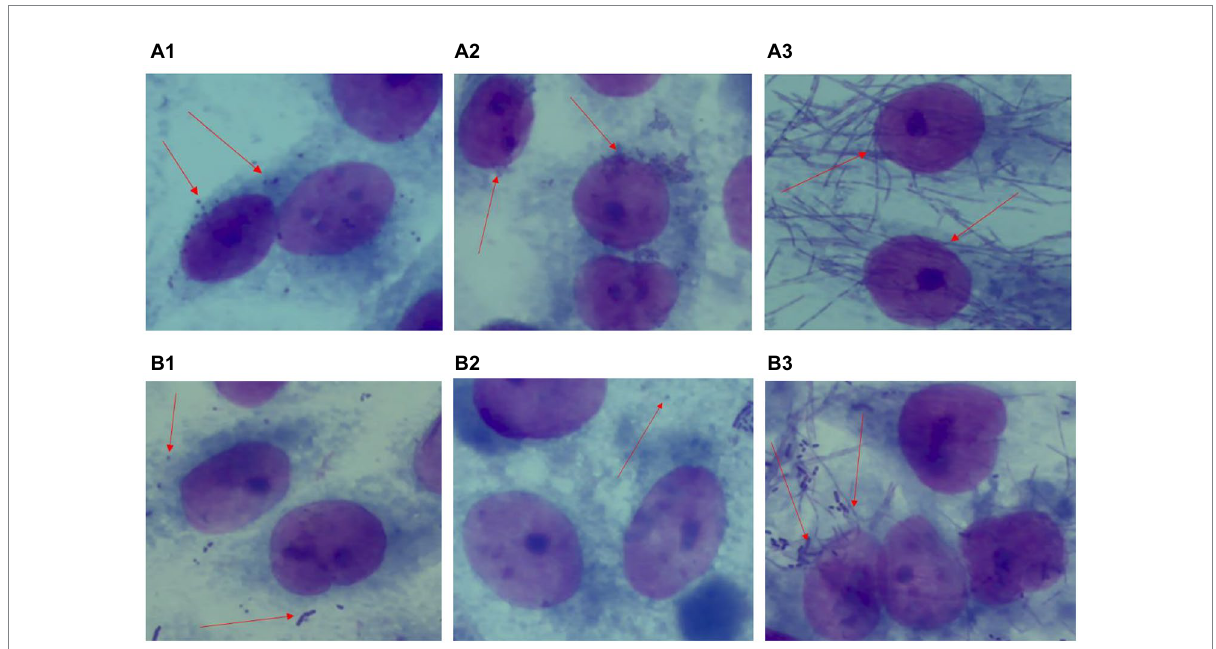
FIGURE 5 Antagonistic adhesion of L. plantarum VHProbi ® V38 to P. gingivalis , A. actinomycetemcomitans and F. nucleatum (A1) control P. gingivalis ; (A2) control A. actinomycetemcomitans ; (A3) control F. nucleatum ; (B1) L. plantarum VHProbi ® V38 + P. gingivalis ; (B2) L. plantarum VHProbi ® V38 + A. actinomycetemcomitans ; (B3) L. plantarum VHProbi ® V38 + F. nucleatum